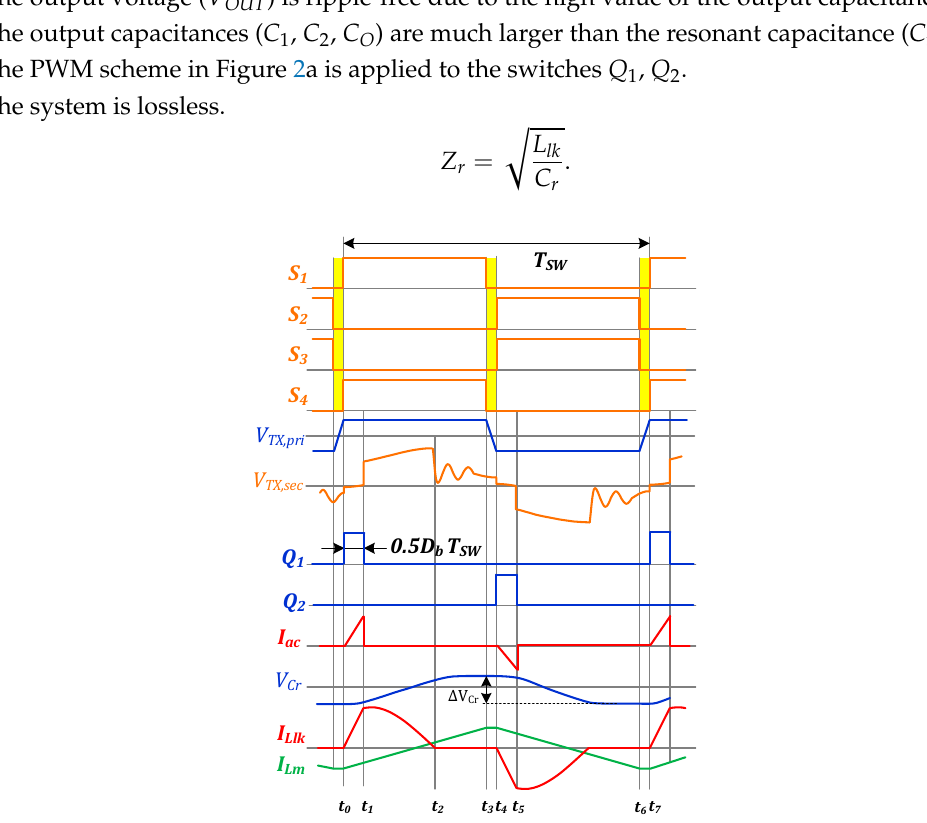
Figure 4. Sketch of idealized voltage and current steady-state waveforms of the proposed converter.